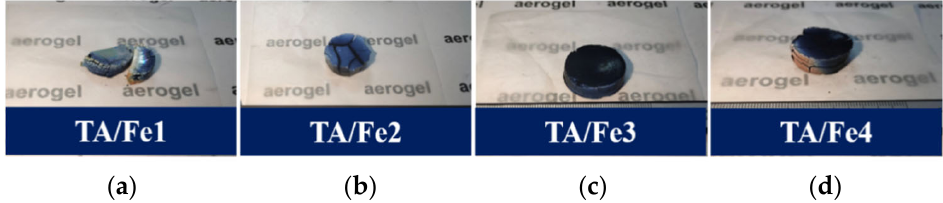
Figure 2. Photographs of TA/Fes: ( a ) doped by Fe(NO 3 ) 3 ∙ 9 H 2 O, ( b ) doped by C 15 H 21 FeO 6 , ( c ) doped by K 4 Fe(CN) 6 ∙ 3H 2 O, and ( d ) doped by Fe 3 O 4 . XRD (X-ray diffraction) analysis was applied to further confirm the phase change of the aerogels. As Figure 3 shows, both anatase (PDF NO.89-4921) and rutile (PDF NO.71-0650) existed in the TA/Fe2, which suggested the appearance of the mixed crystalline phase. In the TA/Fe1, TA/Fe3, and TA/Fe4, only the anatase was formed.